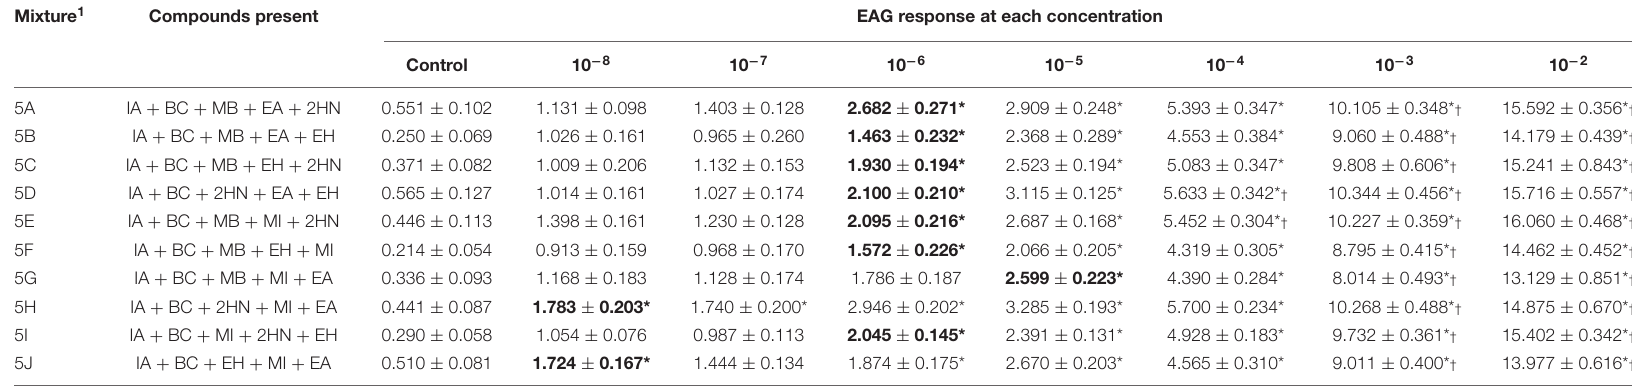
TABLE 6 | Electroantennogram (EAG) responses (mean ± SEM) of male D. suzukii to different concentrations of mixtures with 5 compounds. Mixture